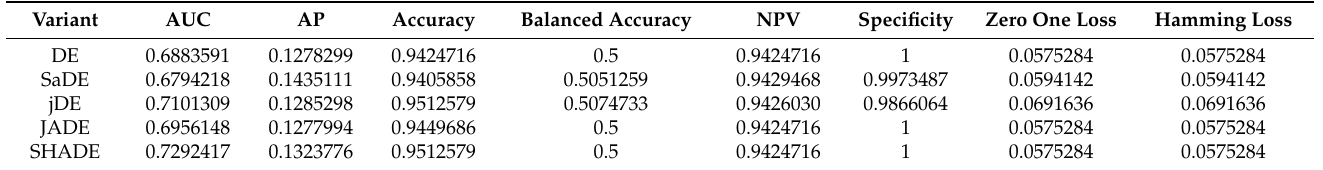
Table 4. Comparison of DE